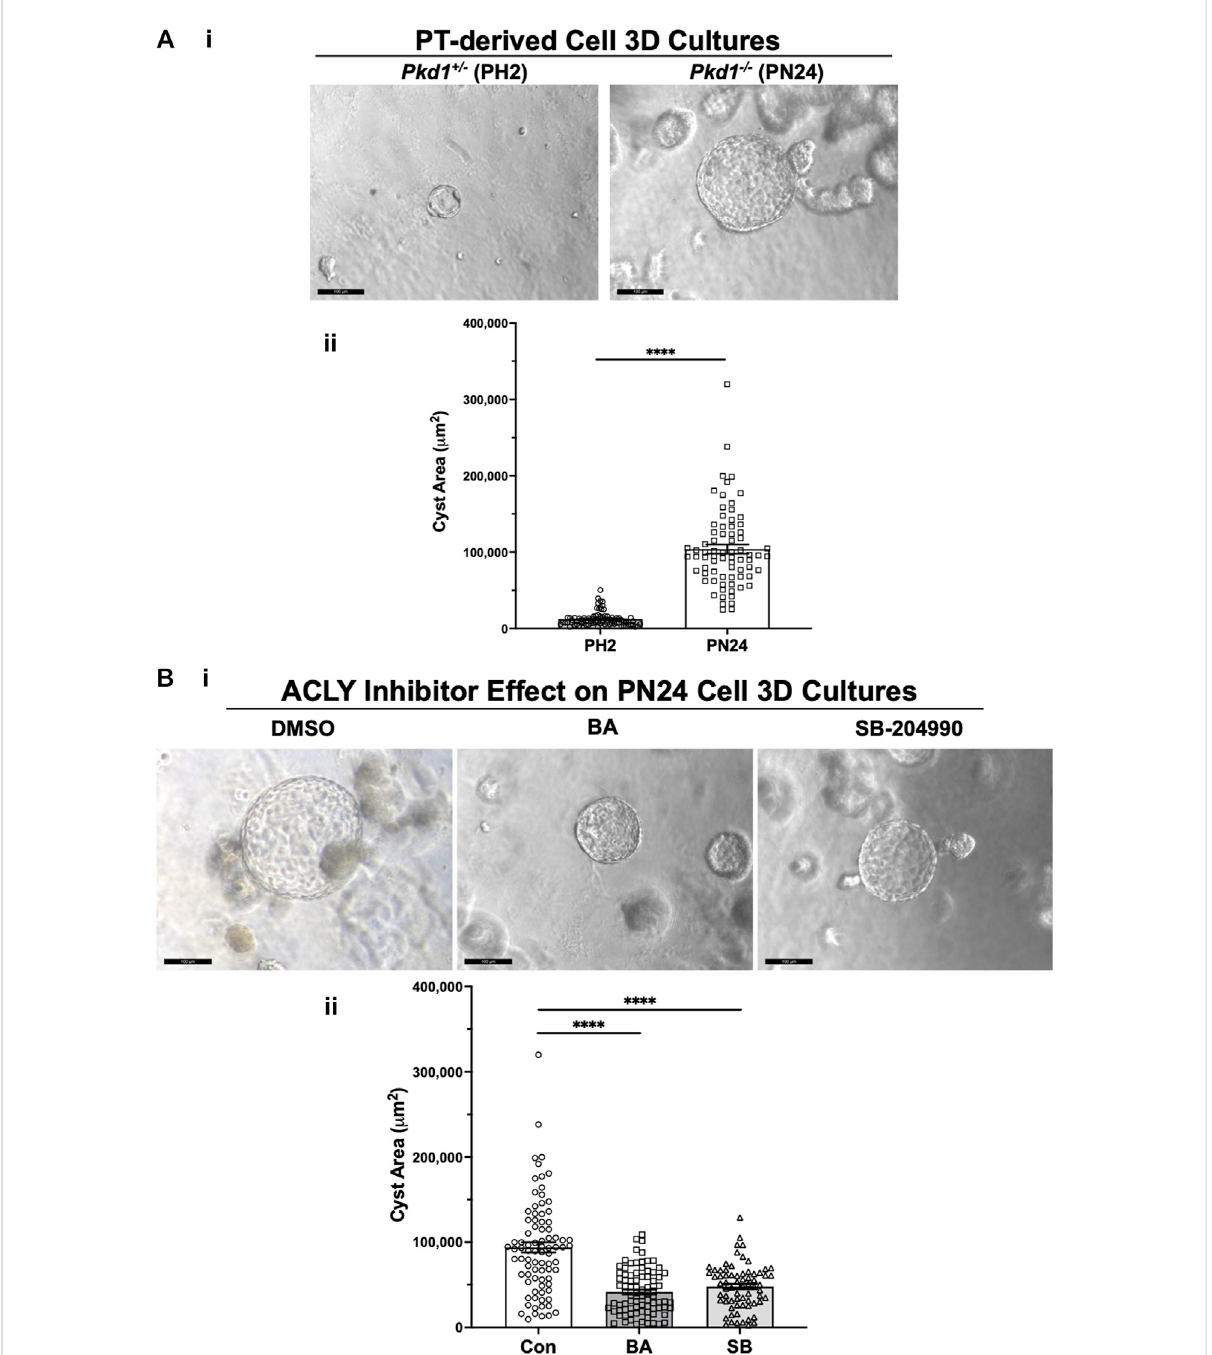
ACLY inhibitors reduce cyst size in 3D cultures of PT-derived Pkd1 − / − (PN24) kidney cells. (A) PT-derived Pkd1 − / − cells (PN24) and Pkd1 +/ − (PH2) cells were grown for 10 – 12 days in Matrigel supplemented with forskolin + IBMX after 1 day, before imaging and cyst size analysis. i Representative light microscopy images of cystic structures from PH2 vs. PN24 3D cultures (scale bar = 100 µm). ii Summary data reveal that PT-derived Pkd1 − / − (PN24) cells developed dramatically bigger cystic structures than Pkd1 +/ − (PH2) ( n = 74 – 82, in a total of 4 independent experiments (**** p